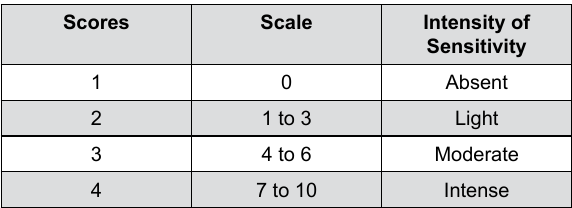
Figure 1- Scores related to the intensity of dental sensitivity